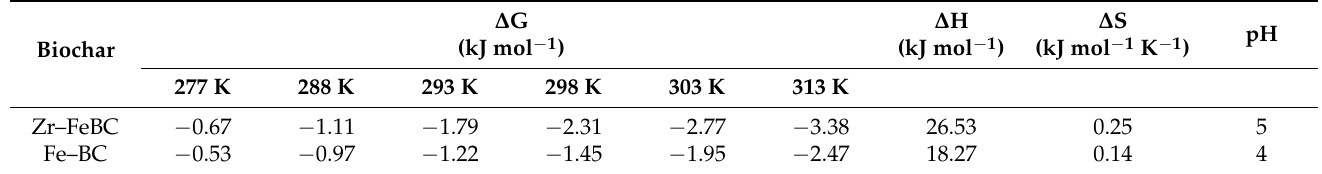
Table 4. Thermodynamic parameters for the P adsorption on